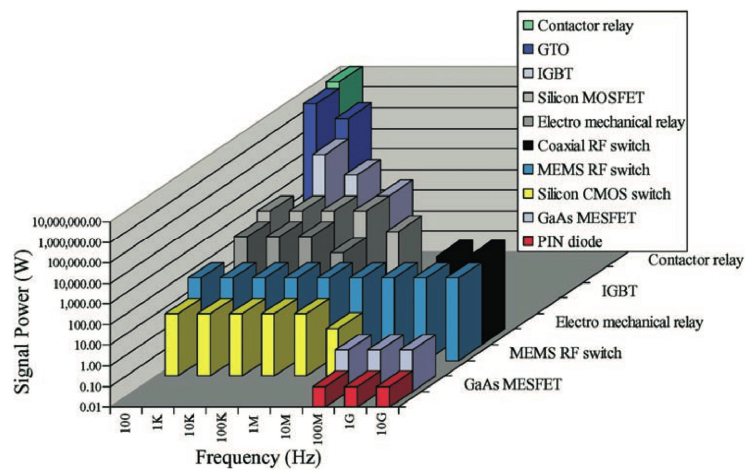
Figure 2. Switch technology applications as a function of signal power levels and frequencies. Reprinted with permission from [76]. Copyright 2000 IOP